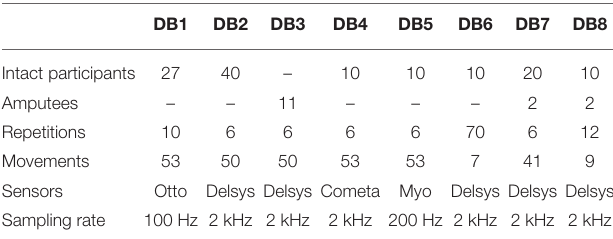
TABLE 1 | Overview of the datasets in the Ninapro